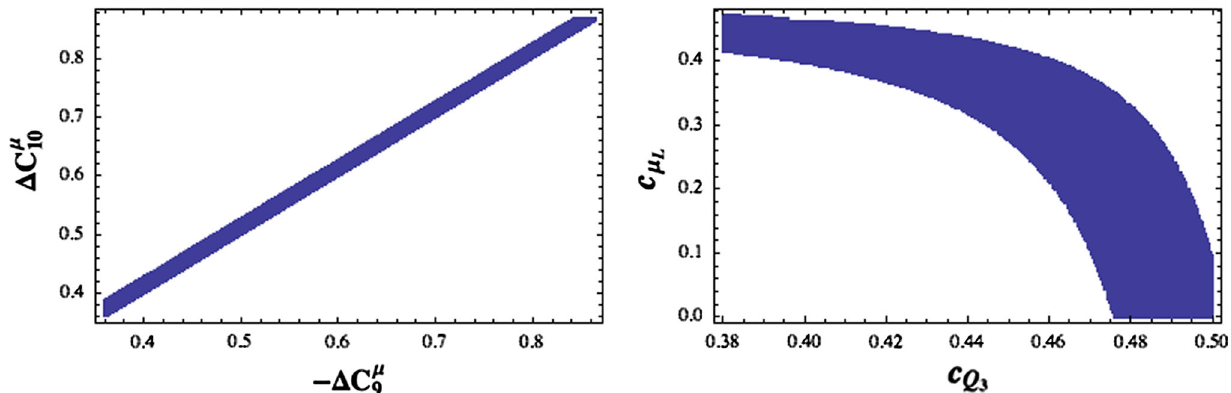
Fig. 5 Scenario B: left plot gives the distribution for (cid:8) C 9 and (cid:8) C 10 . The corresponding c parameters ranges are given in the right plot